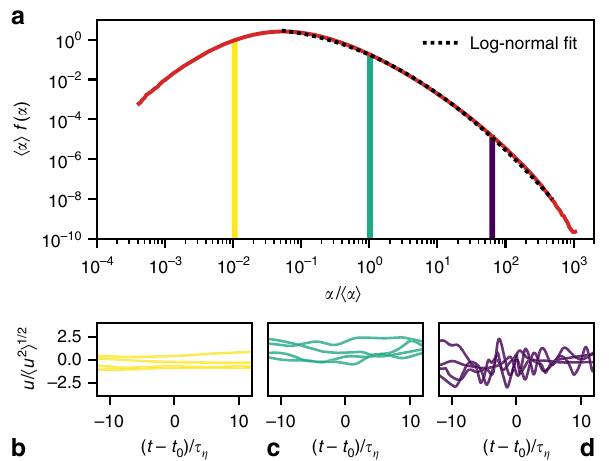
Fig. 2 Distribution of α and velocity time series for various values of α . a The PDF of α for Θ = 3 τ η ; the right tail of the PDF is accurately fi tted by a log-normal distribution (dotted line). b – d Examples of velocity components u ( t ) for trajectories with fi xed values of α ( t 0 ) (the corresponding bins are highlighted in panel a , and colors correspond to the ones in Figs. 3 and 4). Fig. 3 Lagrangian acceleration statistics decomposed into Gaussian sub- ensembles. a The PDFs f ( ɑ | α ) of acceleration components conditional on α (colored lines) are all close to Gaussian. The unconditional PDF (red line) and a Gaussian distribution (black, dashed line) are plotted for comparison. b The conditional second-order moment of the acceleration increases slightly faster than linearly. c The fl atness of the conditional acceleration is close to the Gaussian value three for a large range of α . The conditional ensemble average on α is denoted by 〈 ⋅ | α α (not shown). Figs. 2b – d give an impression of typical velocity